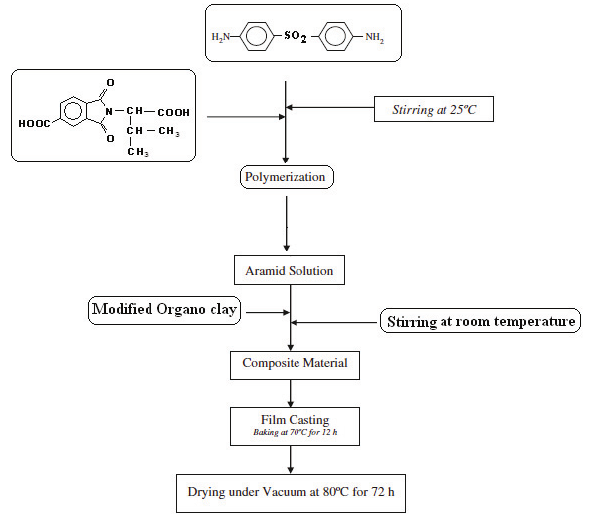
Figure 3. Flow sheet diagram for the synthesis of PAI- nanocomposites film 5a and 5b